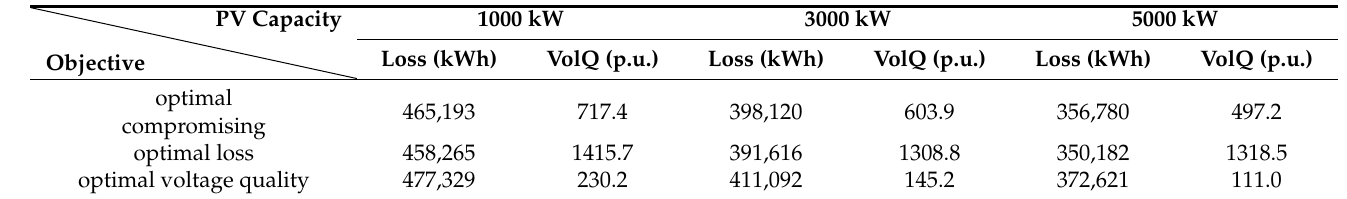
Table 2. Summary of the optimal compromising solution, optimal loss solution, and optimal voltage quality solution.